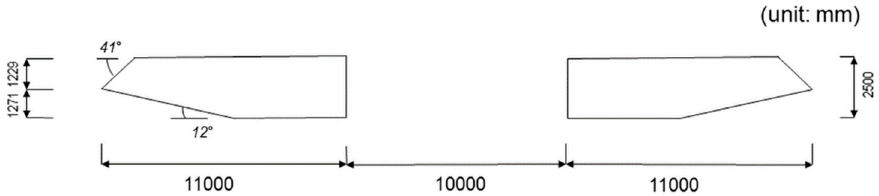
Figure 1. Cross section of the twin-box bridge decks in full scale, reproduced from [25]. Model scale is 1:40.